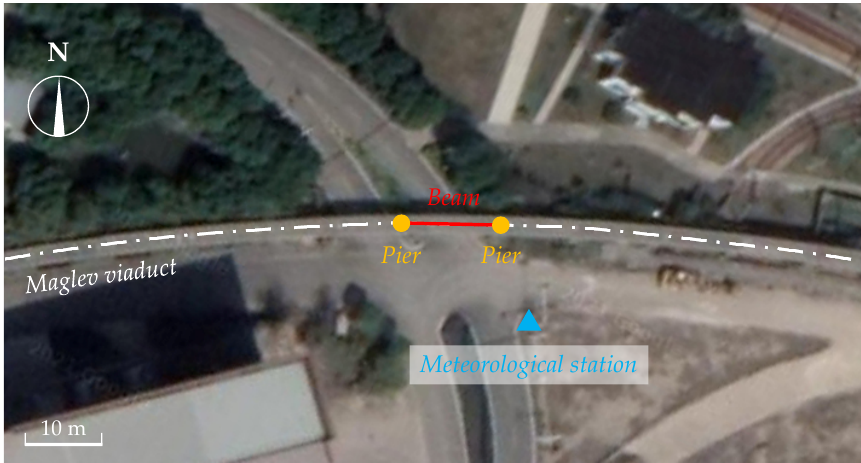
Figure 9. Arrangement of the experimental site.